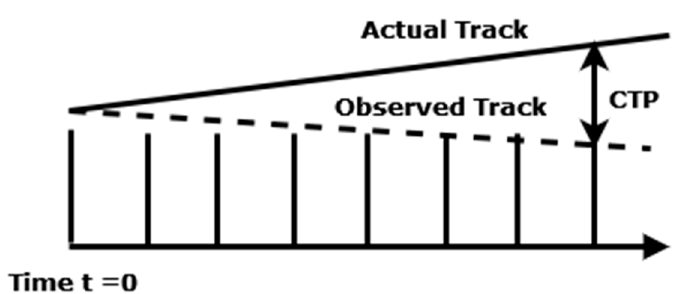
Figure 4. Sample situation of spoofing attack using cross-track positions. An attacker will make minor changes in the GNSS receiver reading so that it can be easily identified. However, the RAIM continuously analyzes the location deviation and error statistics in the GNSS and INS readings. The CTP over time interval t helps to identify the spoofing attack.